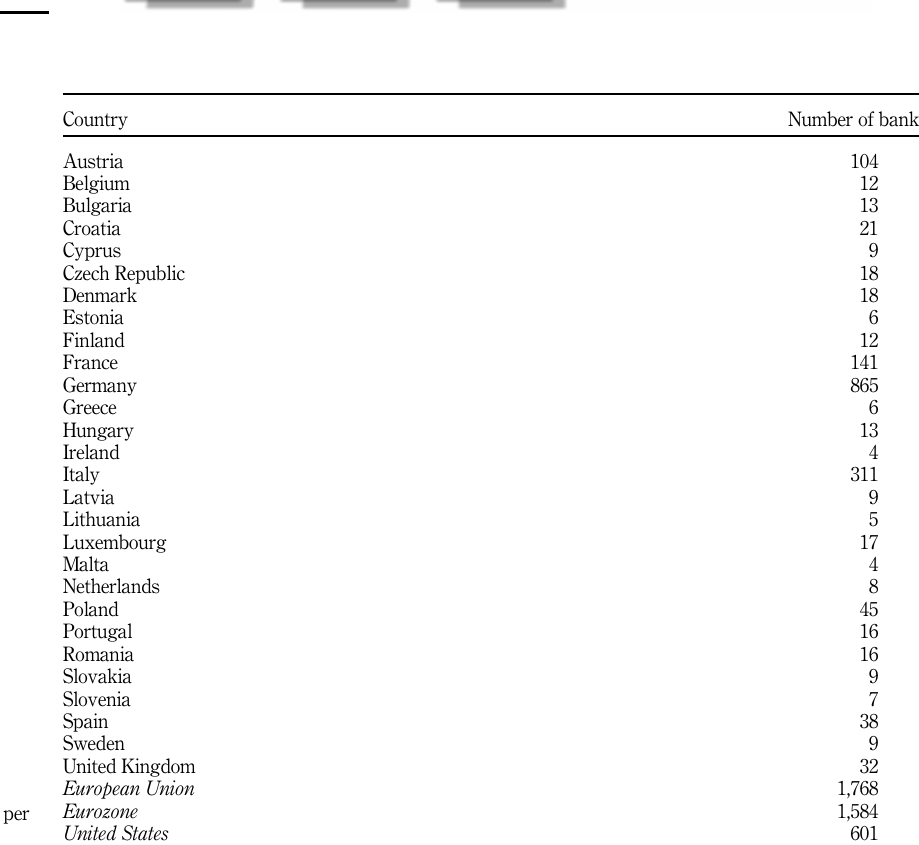
Figure 1. The data sample per banking sector